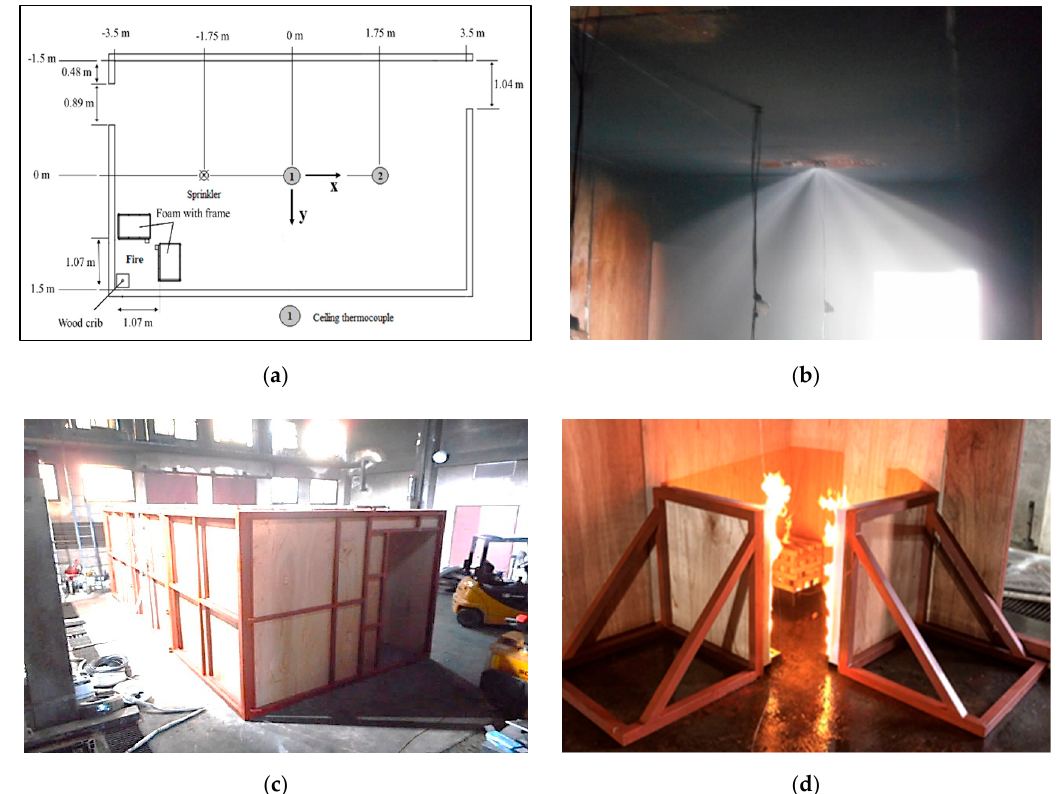
Figure 1. Detailed drawings of the compartment in the experiment: ( a ) test compartment layout; ( b ) sprinkler spray; ( c ) test compartment; and ( d ) fire source.